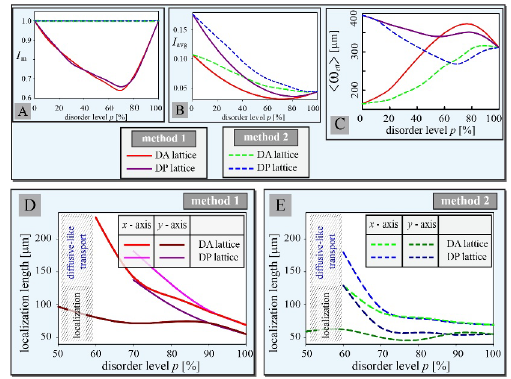
Figure 1. Methods differences of realization and light propaga- tion in DA and DP lattices. (A) I m , (B) I avg of DA and DP lattices versus DL for different methods. (C) (cid:3) ω eff (cid:4) and (D)-(E) localiza- tion lengths along the x - and y -axis for M1 and M2, respectively versus DLs after 10cm of